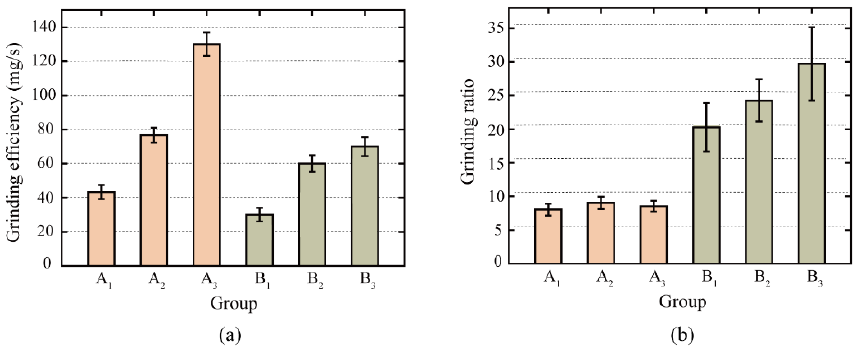
Figure 5. ( a ) Grinding efficiency and ( b ) grinding ratio of grinding wheels at different grinding times.